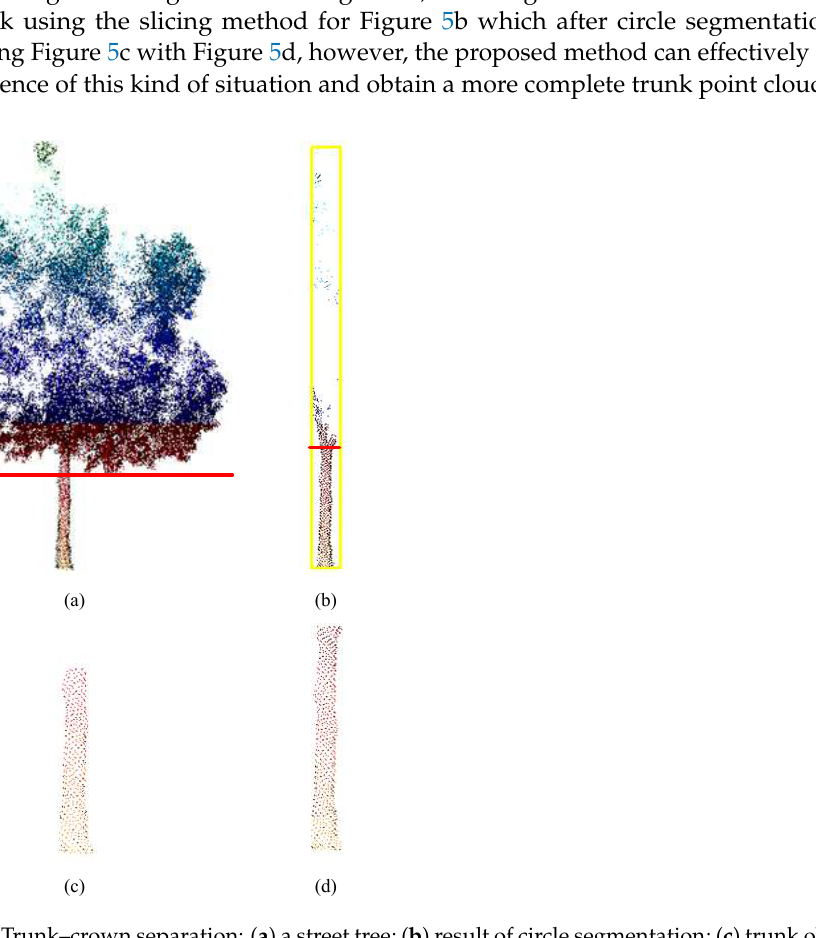
Figure 5. Trunk–crown separation: ( a ) a street tree; ( b ) result of circle segmentation; ( c ) trunk obtained by direct slicing; ( d ) trunk obtained by proposed method.